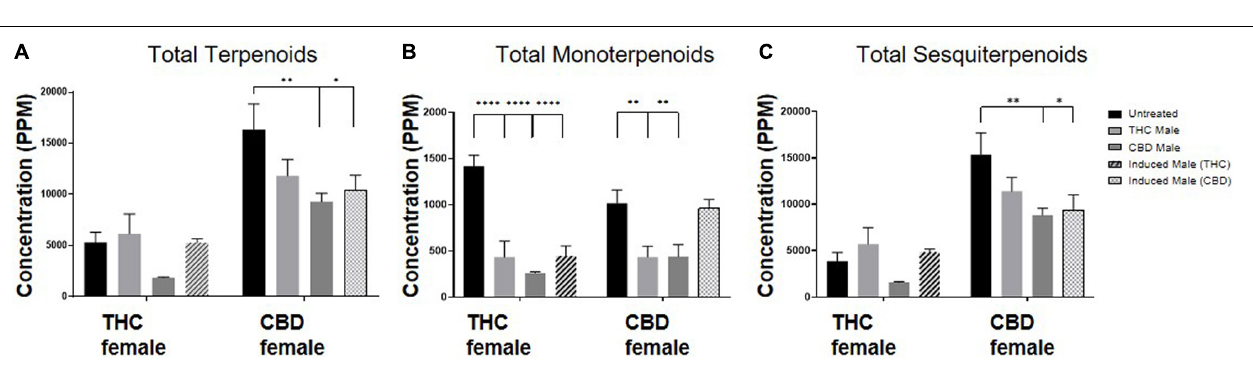
FIGURE 4 | Terpenoid quantity varies after fertilization. Terpenoid concentrations as quantified by SHS-GC/MS/MS of (A) total identified terpenoids, (B) total monoterpenoids and (C) total sesquiterpenoids. Data are reported as mean ± SEM of terpenoid concentrations ( n = 3–4, ppm). Statistically significant differences between treatments and control (unfertilized) were calculated by two-way ANOVA followed by Dunnett’s multiple comparison test (* p ≤ 0.05; ** p ≤ 0.01; **** p ≤